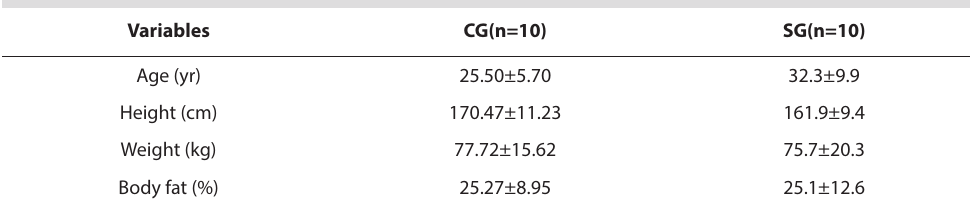
TABLE 1. The Physical Characteristics of the